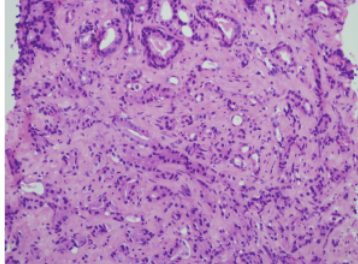
Figure 3: Squamous cell carcinoma in situ of the anus with underlying invasion from biopsy (hematoxylin and eosin,